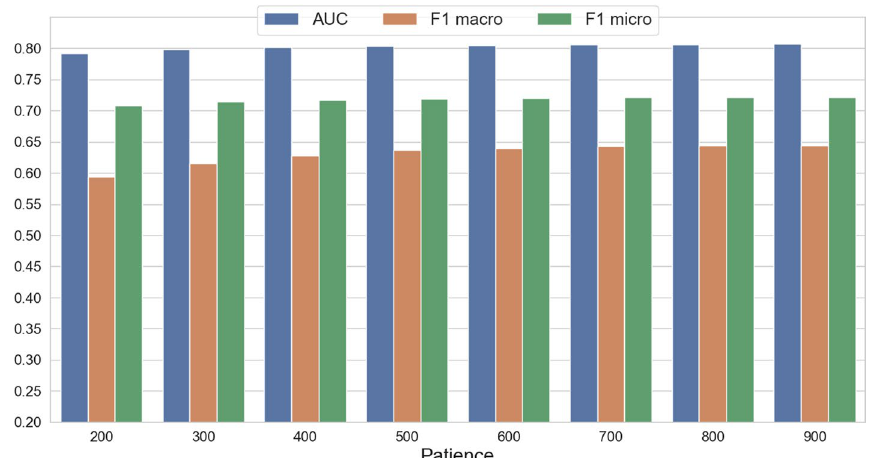
Fig. 11 Quality criteria of the final classifier with different patience values. The best performance is reached with patience equal to 900: 0.807 AUC, 0.645 F1 macro, 0.721 F1 micro